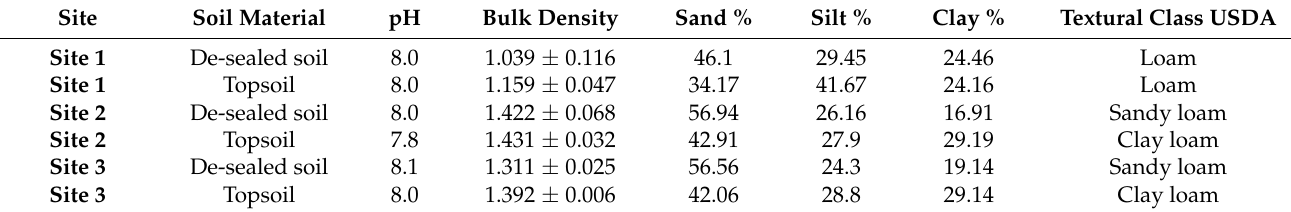
Table 2. Physical characteristics of topsoil and de-sealed soils from three sites at T0 n = 3.